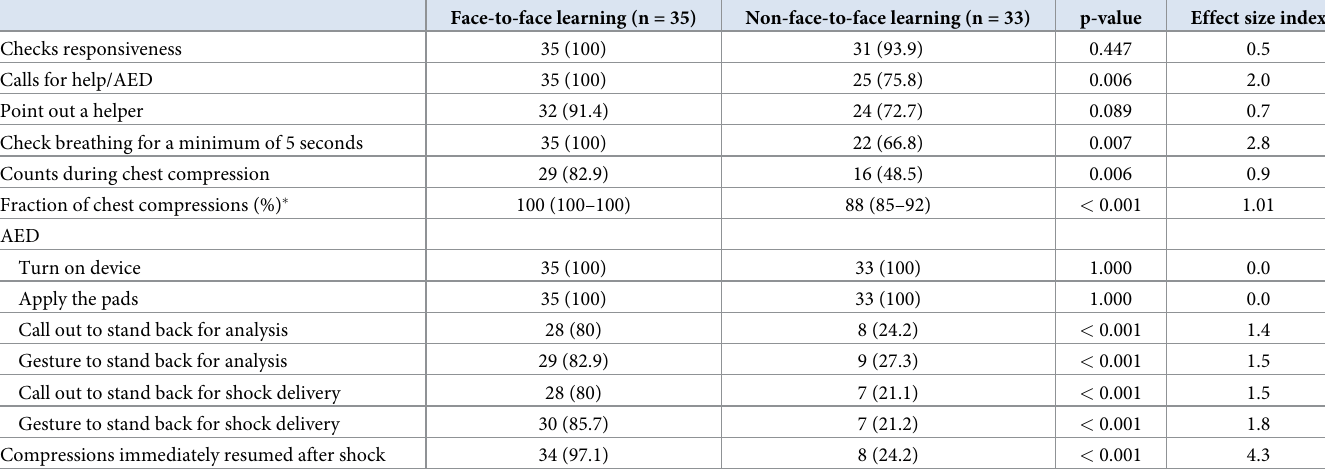
Table 3. Comparison of class participation between the face-to-face and non-face-to-face learning